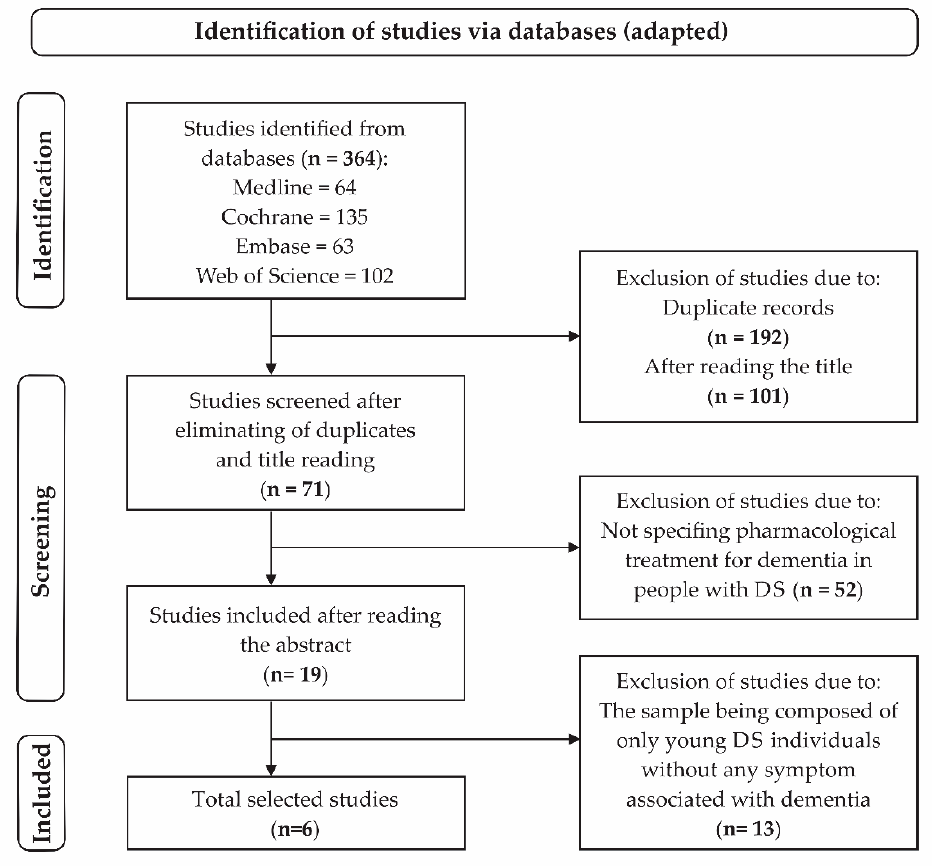
Figure 1. Flowchart of the search process of the selected studies [28].